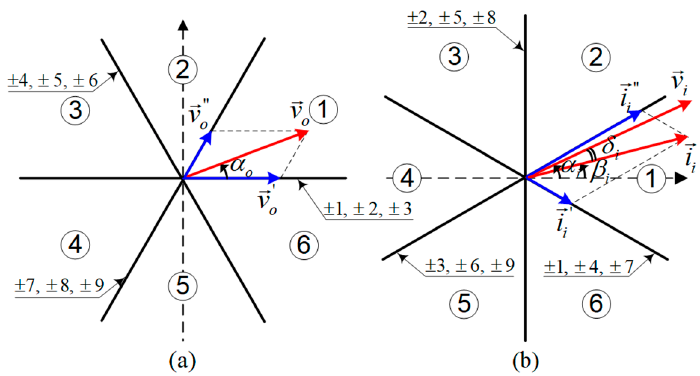
Figure 2. The location of ( a ) the output voltage vector and ( b ) the input current vector.